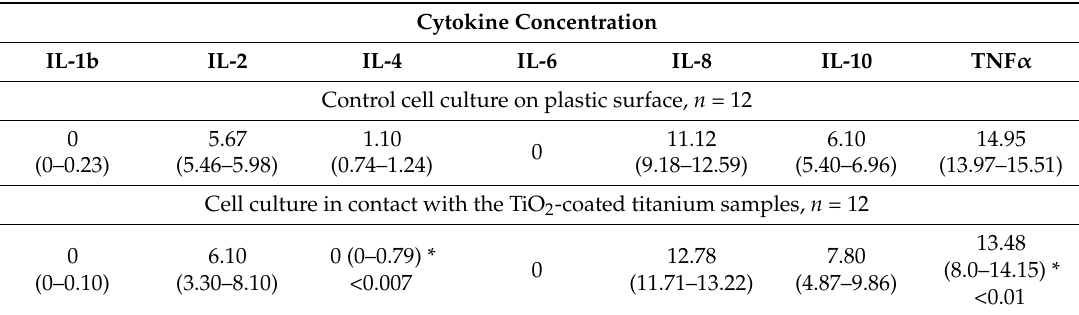
Table 5. Cytokine concentrations (pg/mL) in the supernatants of Jurkat T cells after 24 h of culture in the presence of a TiO 2 coating, Me (Q 1 –Q 3